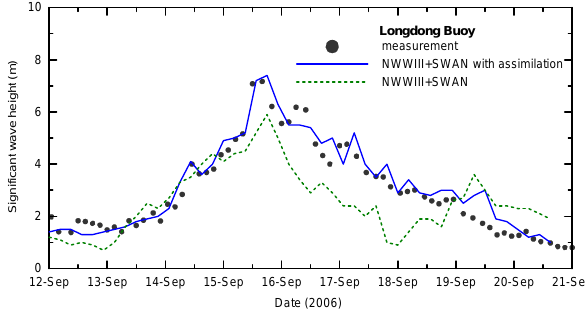
Figure 11 Improvement of wave forecast by data assimilation technique